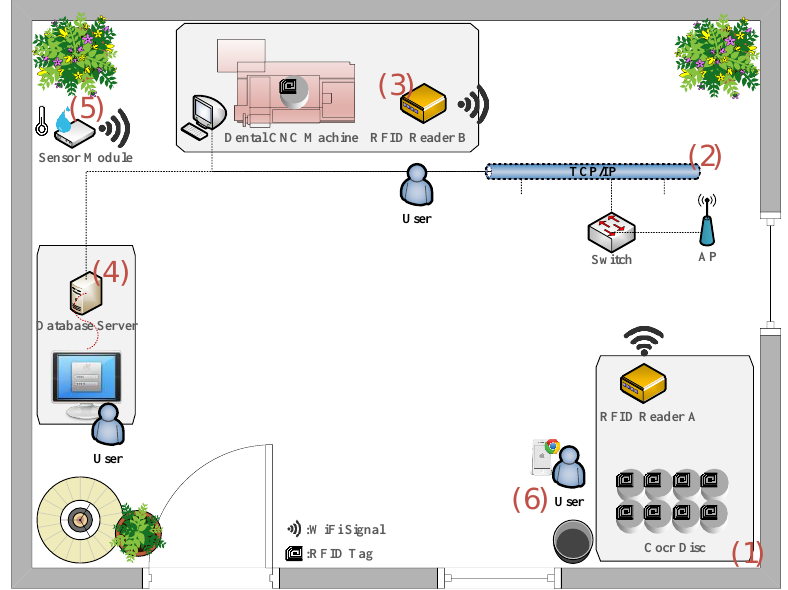
Figure 1. The system architecture of the dental laboratory automated management system.